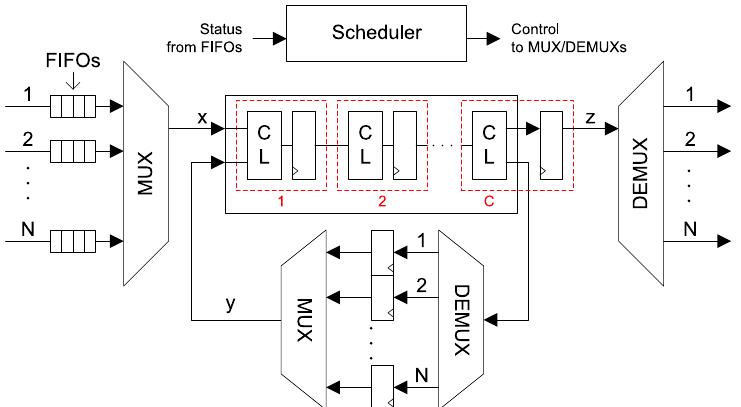
Figure 9. Virtualized hardware with scheduler. Inputs to the scheduler are the status from the FIFOs. Outputs from the scheduler are the control signals to the